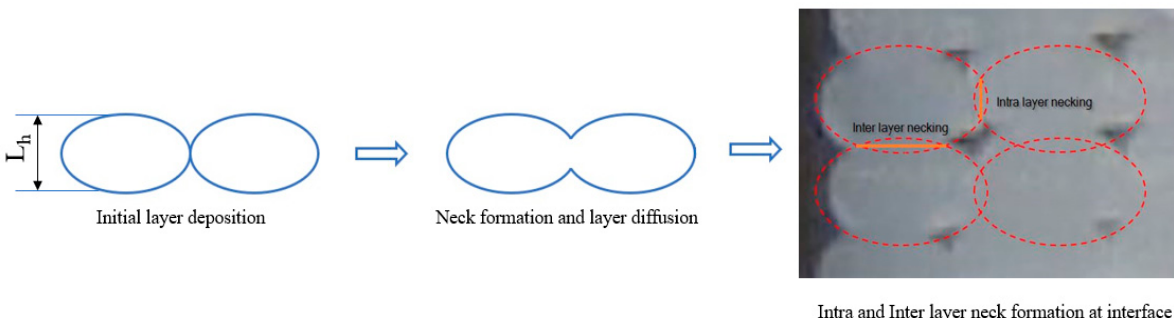
Figure 6. Necking formation between adjacent raster layers.